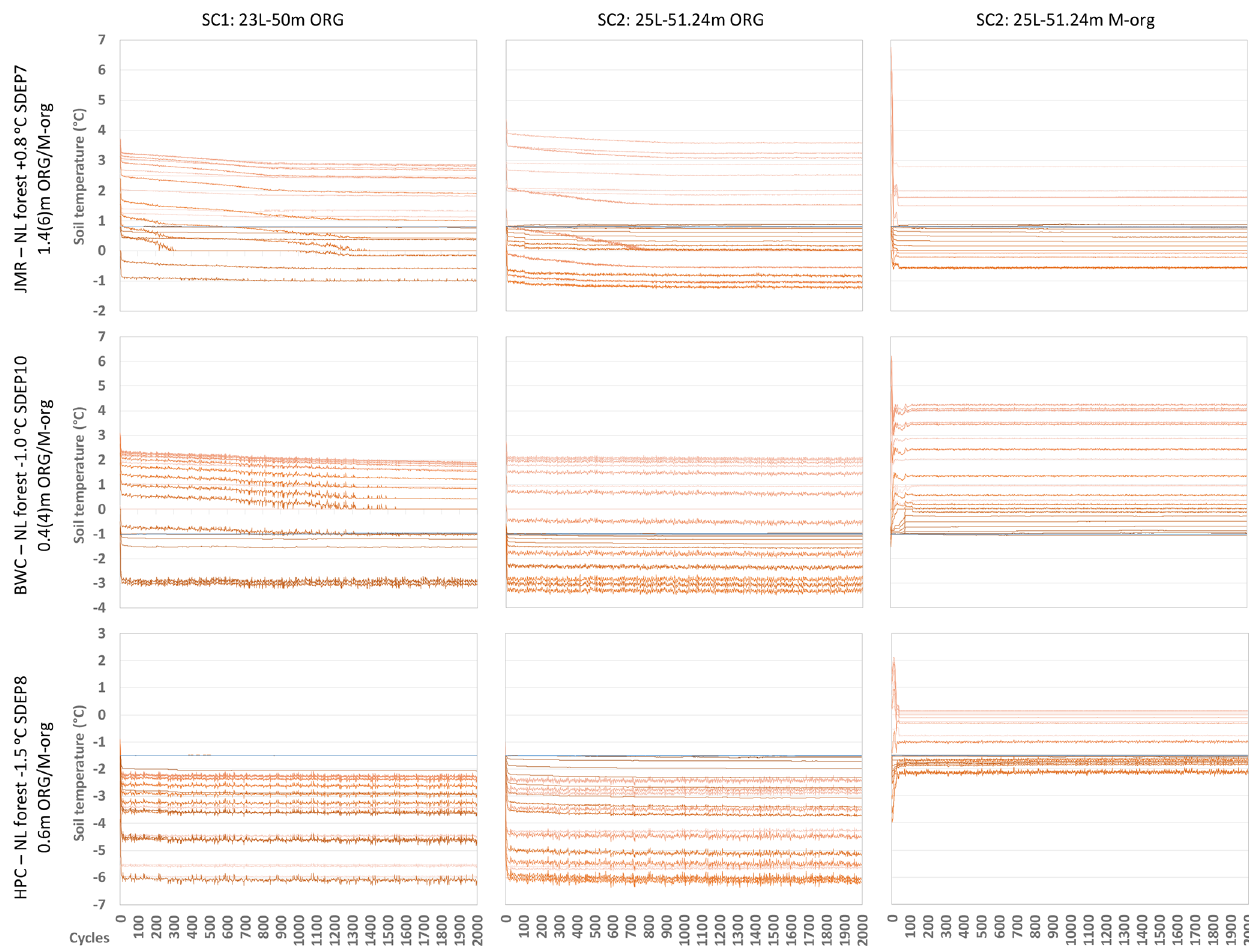
Figure 7. Impact of the soil layering scheme selection on spin-up convergence at the three study sites (the darker the colour, the deeper the layer; the deepest layer is coloured blue).